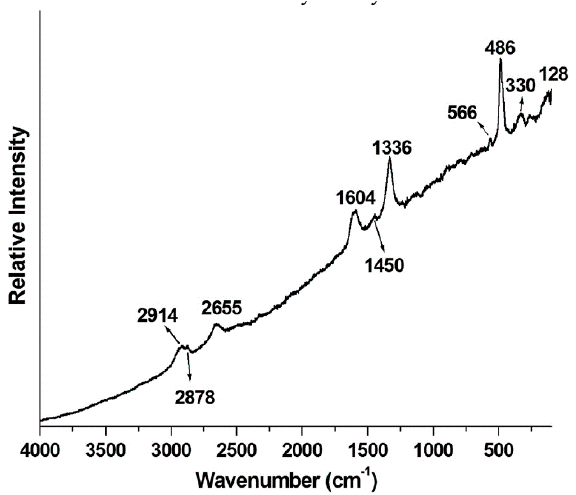
Figure 8. Raman spectra obtained in the 4000–100 cm − 1 range on a dark grain on the surface of North Dakota erionite fibers.